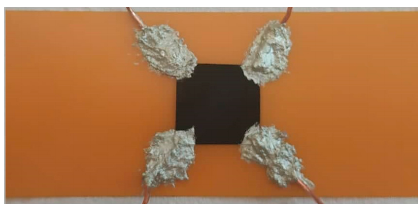
Figure 1. Appearance of a test sample.